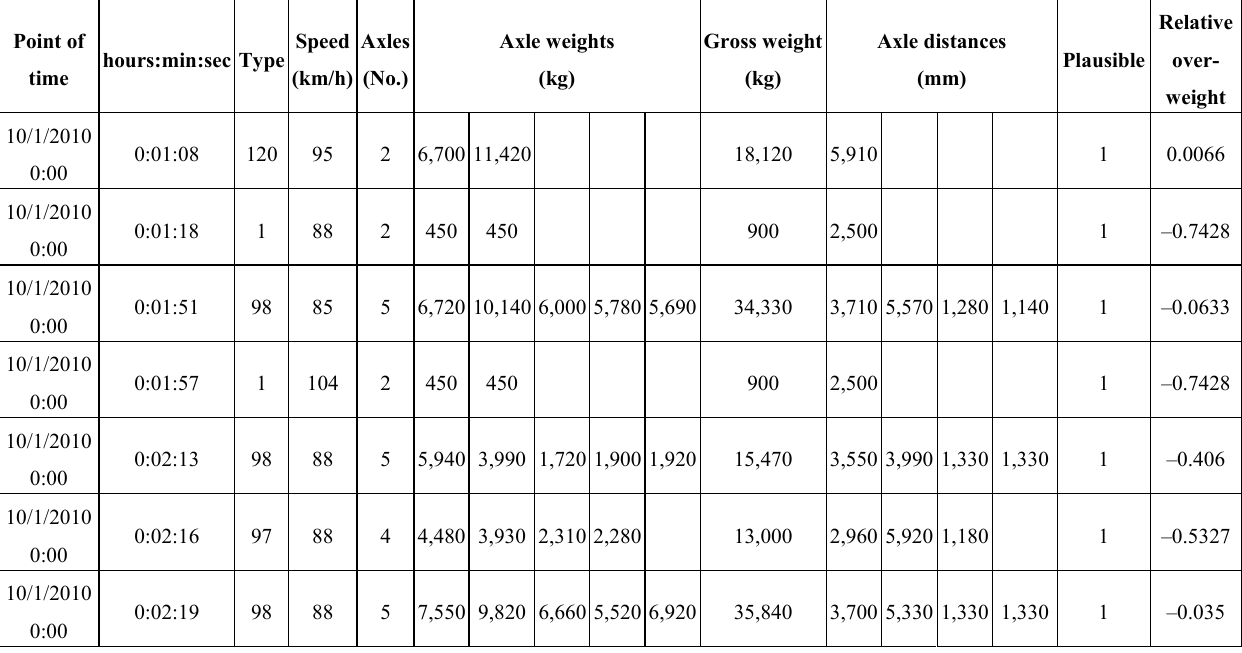
Table 4. Data recorded by the Rosenheim (Germany) WIM station